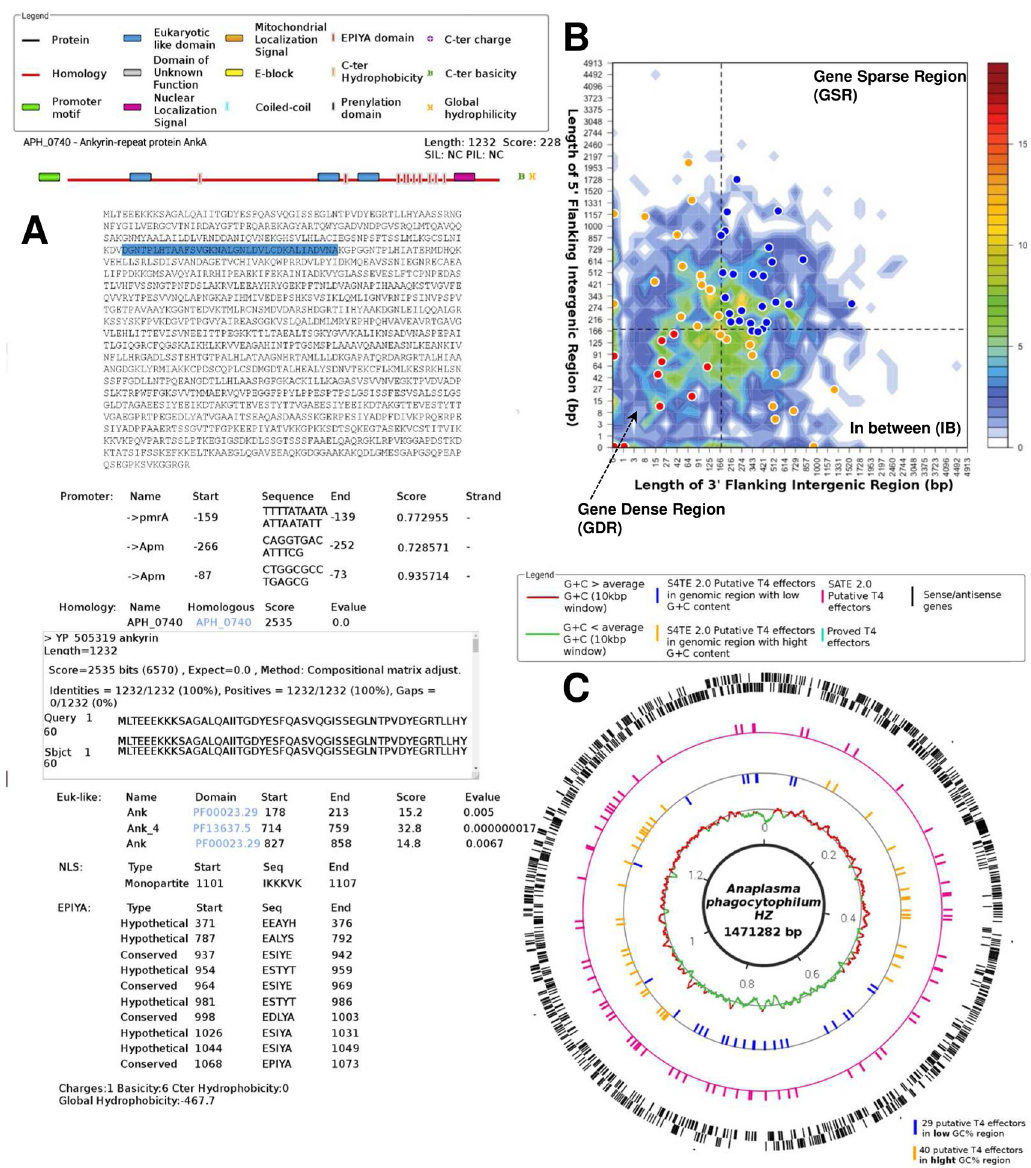
Fig 4. Example of S4TE 2.0 results for Anaplasma phagocytophilum HZ. APH-0740. (A) Schematic representations of proteins with different characteristics present in the sequence are shown. Characteristics are easy to find by highlighting the corresponding sequence in the effector sequence. These characteristics are detailed below the sequence. (B) Distribution of S4TE 2.0 predicted type IV effectors (T4Es) according to local gene density. The predicted T4Es are plotted according to the length of their flanking intergenic regions (FIRs). All A. phagocytophilum genes were sorted into 2-dimensional bins according to the length of their 5 0 (y- axis) and 3 0 (x-axis) FIRs. The number of genes in the bins is represented by a color-coded density graph. Genes whose FIRs are both longer than the median FIR length were considered as gene-sparse region (GSR) genes. Genes whose FIRs are both below the median value were considered as gene-dense region (GDR) genes. In-between region (IBR) genes are genes with a long 5 0 FIR and short 3 0 FIR, or inversely. Candidate T4Es predicted using the S4TE 2.0 algorithm were s plotted on this distribution according to their own 3 0 and 5 0 FIRs. A color is assigned to each of the three following groups: Red to GDRs, orange to IBRs, and blue to GSRs. (C) Genome-wide distribution of predicted effectome according to the G+C content. From outer track to inner track, sense and antisense genes (black), S4TE 2.0 putative T4Es (pink), proved T4Es (turquoise), S4TE 2.0 putative T4Es in genomic region with low G+C content (yellow), S4TE 2.0 putative T4Es in genomic region with high G+C content (blue), G+C � average G+C (red), G +C < average G+C (green).